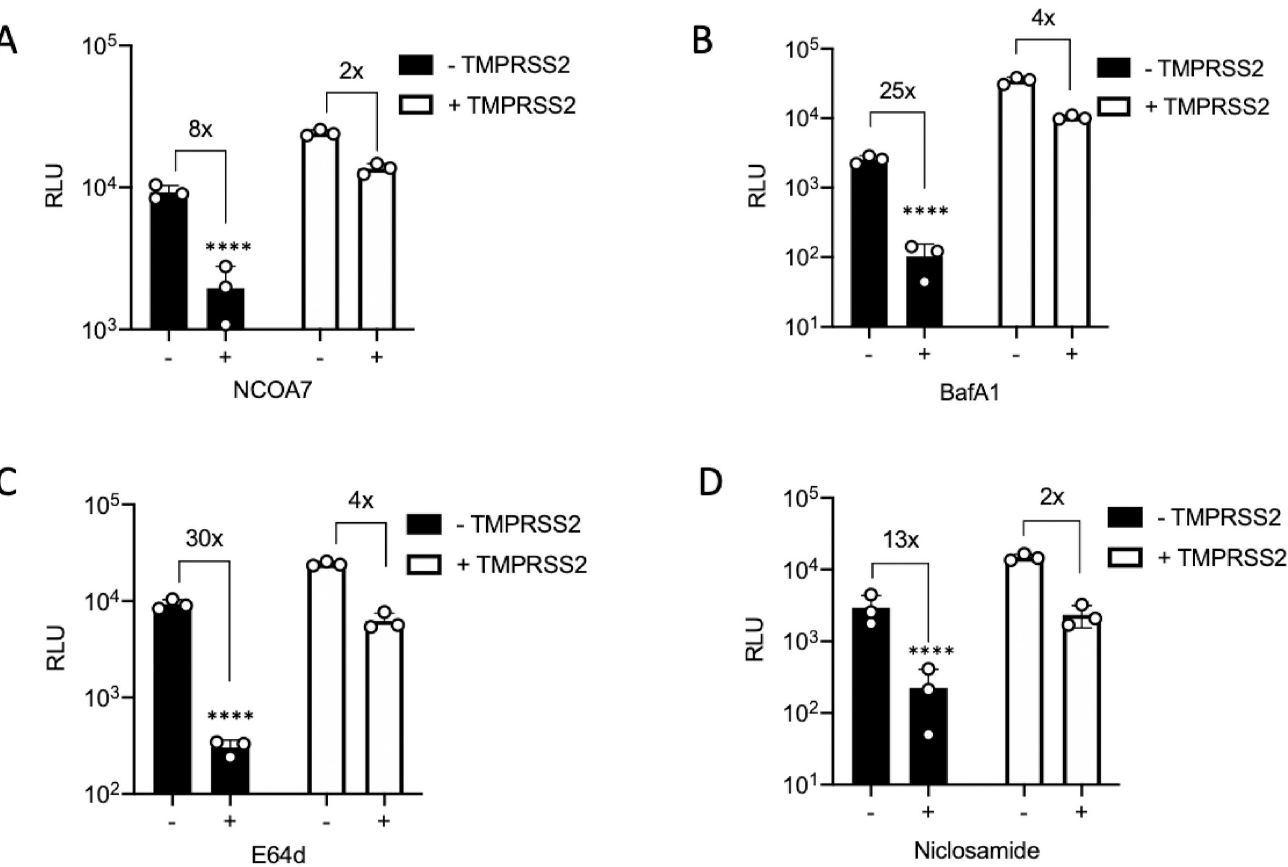
Fig 4. TMPRSS2 attenuates SARS-CoV-2 inhibition by endo-lysosomal pathway inhibitors. (A) A549-ACE2 cells with or without NCOA7 and TMPRSS2 were infected with SARS-CoV-2 Spike pseudotyped vector expressing luciferase. Luciferase activity was measured 48 h post-infection. (B) A549-ACE2 cells with or without TMPRSS2 were treated with 100 nM BafilomycinA1 (BafA1: V-ATPase inhibitor) or left untreated for 2 h and then infected with SARS-CoV-2 Spike pseudotyped vector expressing luciferase. Luciferase activity was measured 48 h post-infection. (C) A549-ACE2 cells with or without TMPRSS2 were treated with 10 μ M E64d (cathepsin inhibitor) or left untreated for 2 h and then infected with SARS-CoV-2 Spike pseudotyped vector expressing luciferase. Luciferase activity was measured 48 h post-infection. (D) A549-ACE2 cells with or without TMPRSS2 were treated with 5 μ M Niclosamide (neutralise pH) or left untreated for 2 h and then infected with SARS-CoV-2 Spike pseudotyped vector expressing luciferase. Luciferase activity was measured 48 h post-infection. For all the data n = 3, mean +/- SD. All analysed using two-way ANOVA. � (p < 0.05), �� (p < 0.01), ��� (p < 0.001), ���� (p < 0.0001).